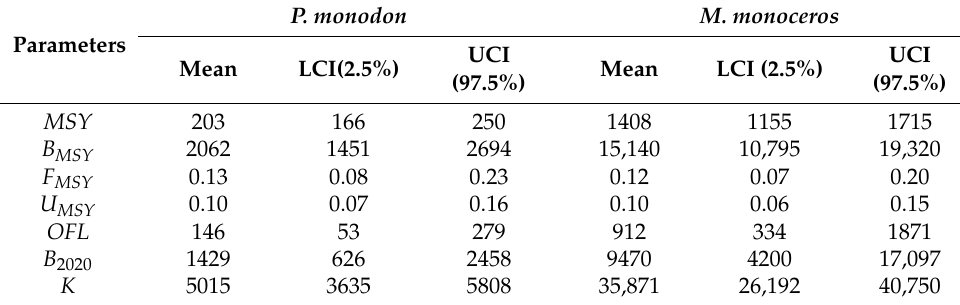
Figure 4. Estimated reference points by the DB-SRA model from accepted (black) and rejected (white) model runs.